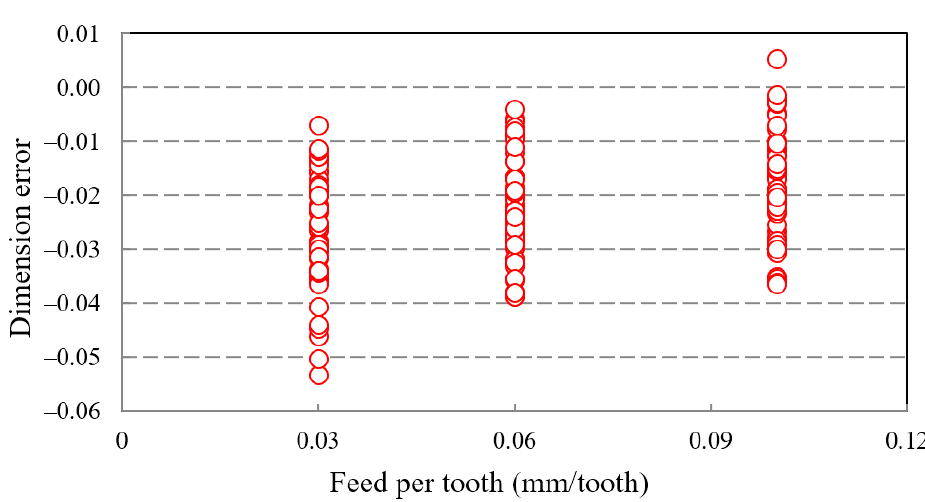
Figure 18. Distribution graph of dimensional accuracy in terms of feed per tooth.